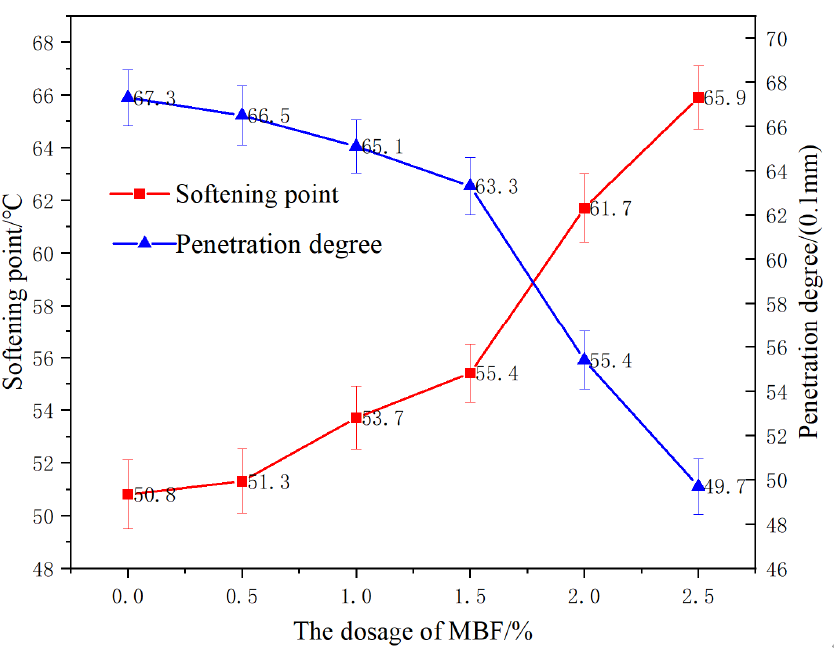
Figure 10. Effect of coupling-modified fiber content on the penetration and softening point of evaporative residue.